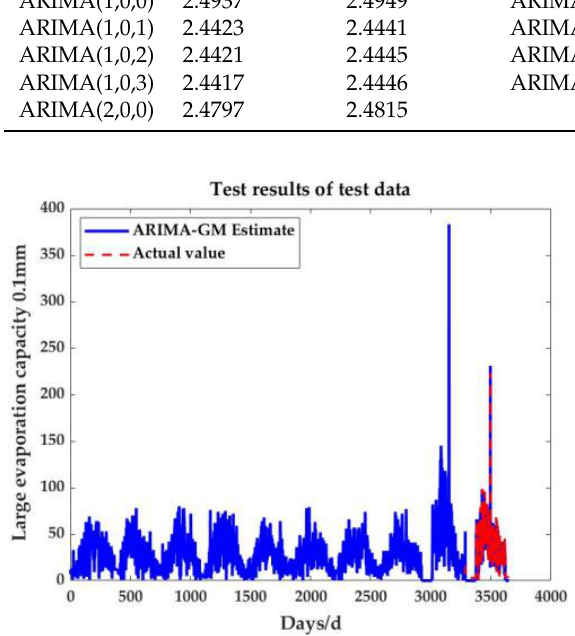
Figure 9. Comparison chart of test results.